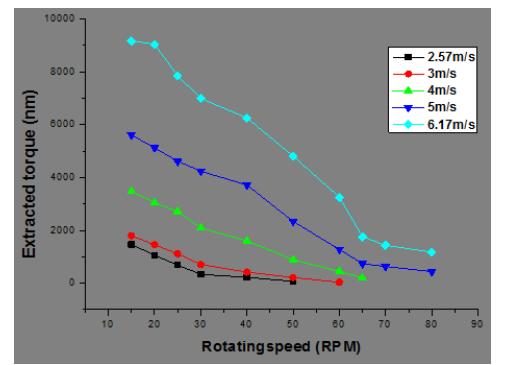
Figure 7. Extracted torque variation with inlet flow speed and rotat- ing speed.